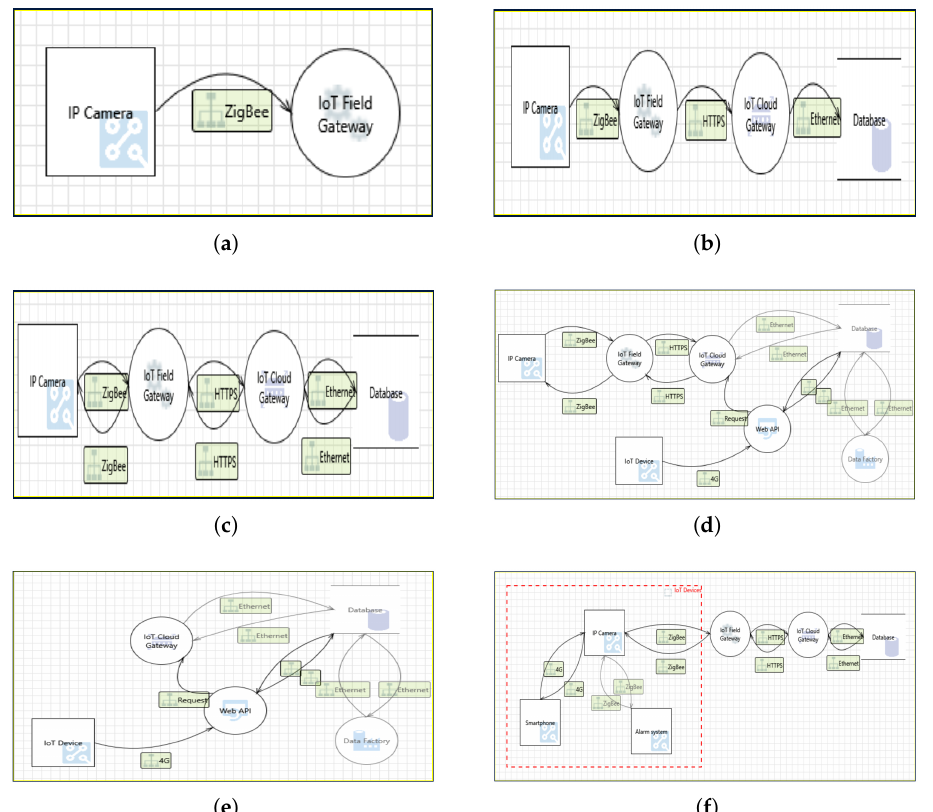
Figure 1. Developed Scenarios [8]. ( a ) IP camera and IoT gateway [8]. ( b ) Unidirectional communication between an IP camera and the cloud [8]. ( c ) Bidirectional communication between an IP camera and the cloud [8]. ( d ) Smartphone controlled IP camera [8]. ( e ) Smartphone communication with the Cloud [8]. ( f ) Links among smart devices